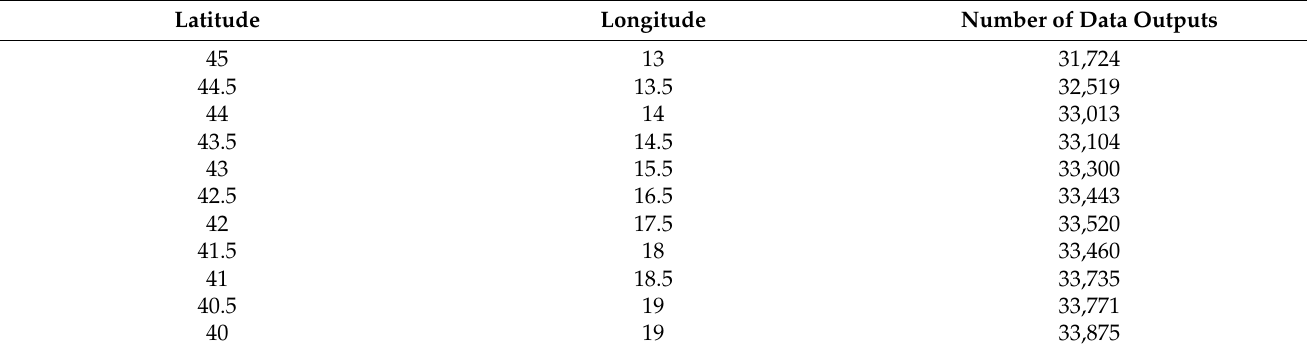
Table 1. Analyzed locations for the Adriatic